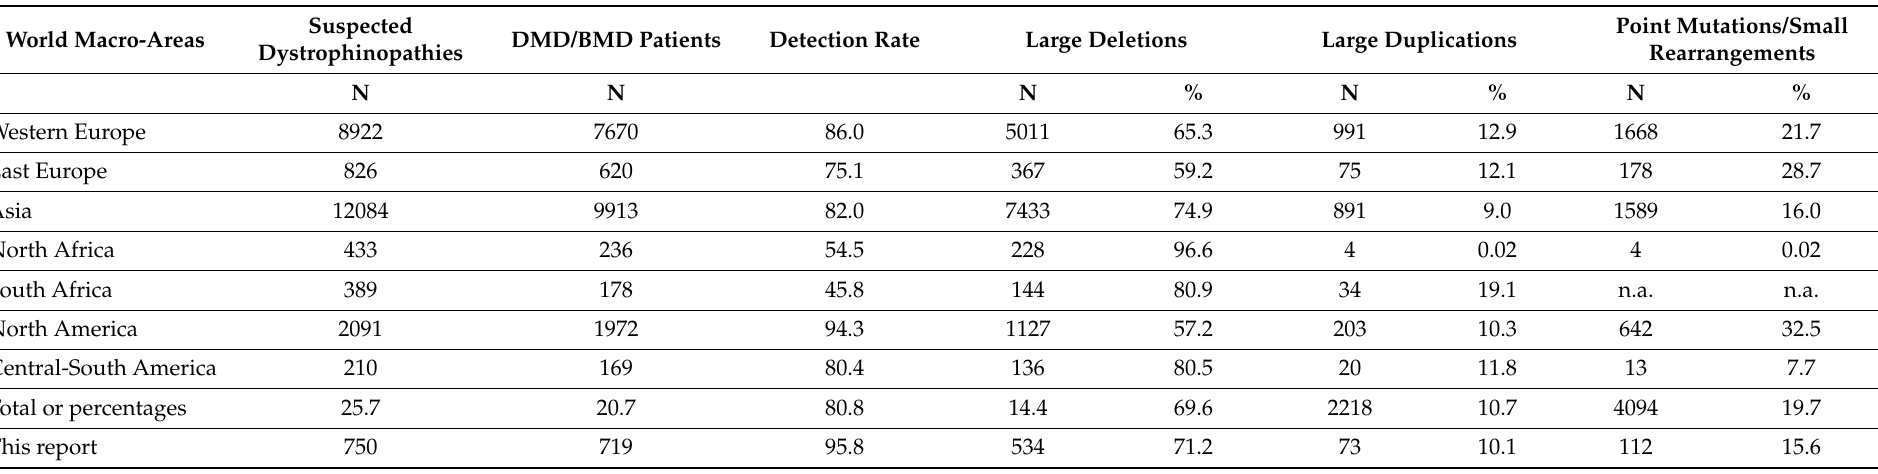
Table 2. Summary of average frequencies of DMD gene variants identified in the seven considered macro-areas in the